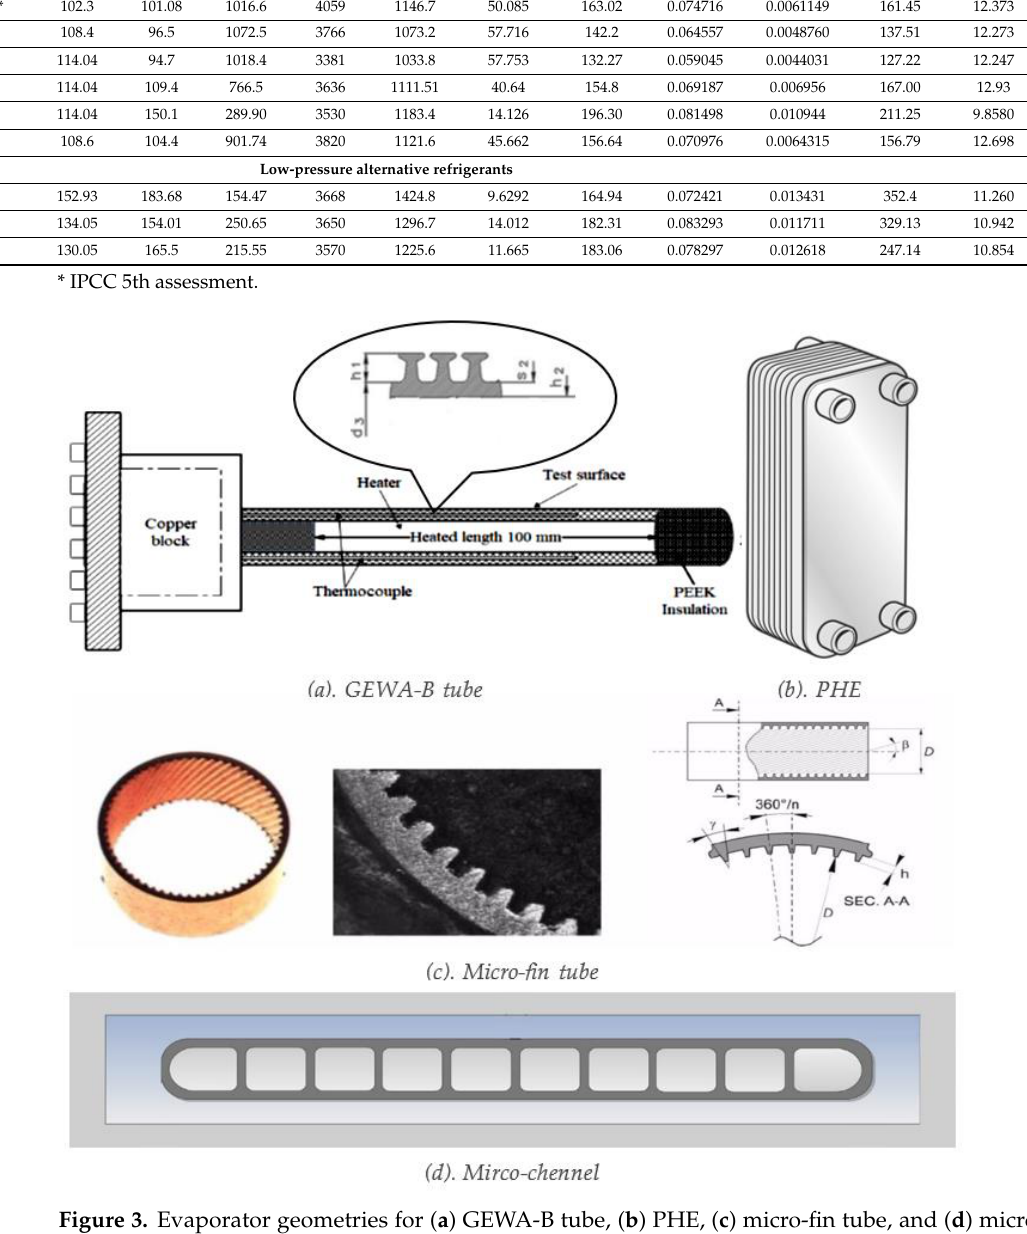
Figure 3. Evaporator geometries for ( a ) GEWA-B tube, ( b ) PHE, ( c ) micro-fin tube, and ( d ) micro-channel under discussion in this review [18 – 20].